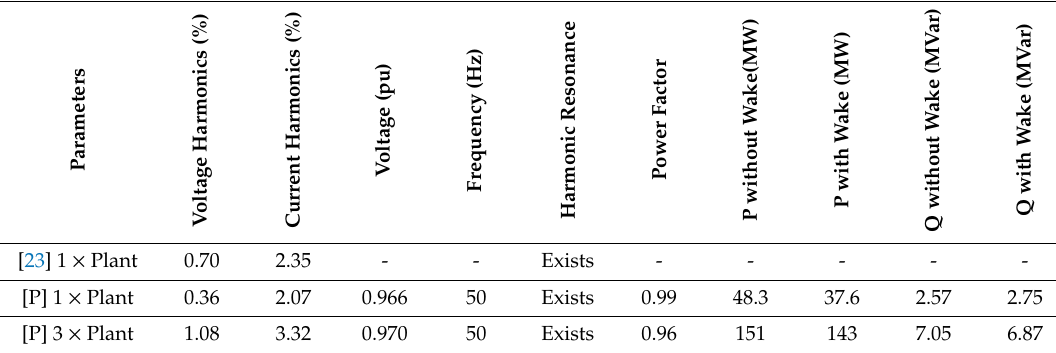
Table 4. Comparison of proposed work with reported